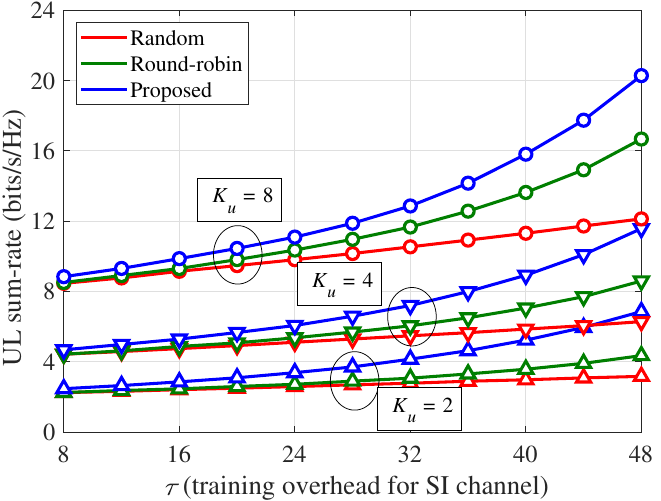
Figure 5. UL sum-rate ( ∑ k R u , k ) per channel use according to the number of UEs ( K u ) and SI training overhead ( τ ): α = 70 dB, κ ij = 3, and 80 dB path loss between the BS and